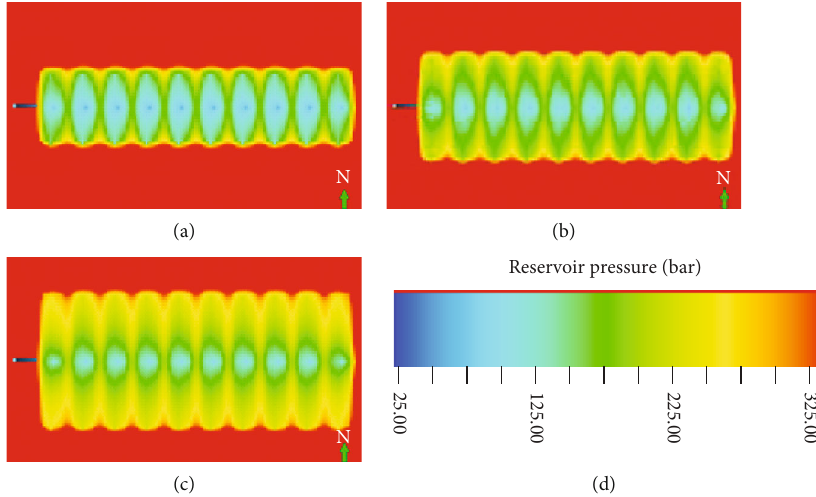
Figure 10: Pressure drop at the end of production with di ff erent fracture lengths: (a) the fracture length is 200m, (b) the fracture length is 300m, (c) the fracture length is 400 m, and (d) the legend of reservoir